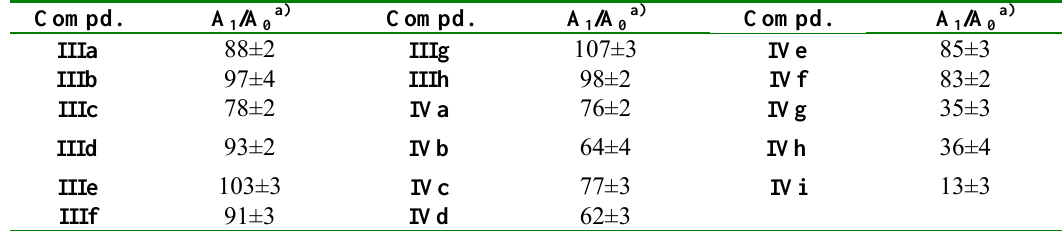
a) Compd. A /A 1 0